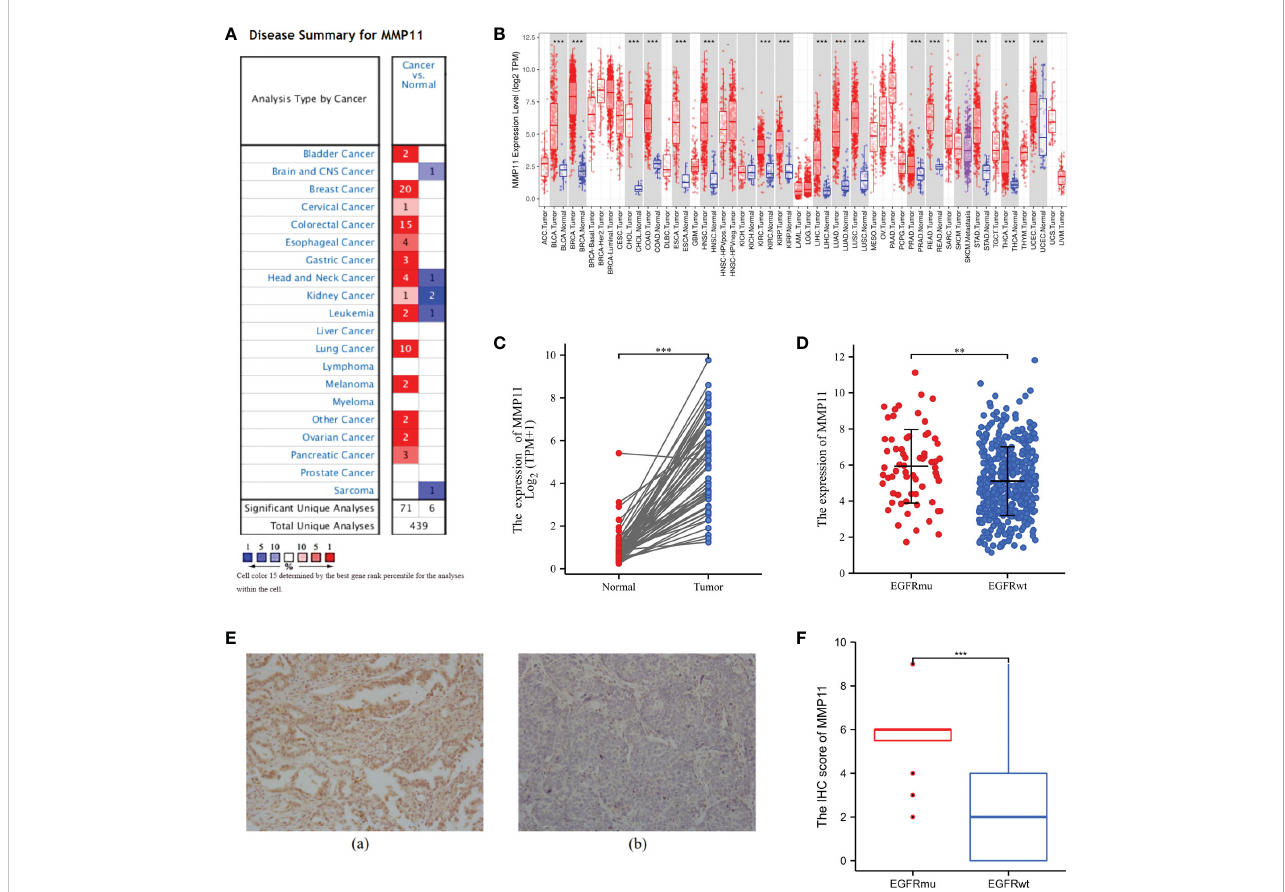
FIGURE 1 Differential expression of MMP11. (A) Differential expression of MMP11 in different tumor tissues and normal tissues in the Oncomine database; (B) Differential expression of MMP11 in different tumor tissues and normal tissues in the TIMER database; (C) Differential expression of MMP11 in LUAD tissues and paraneoplastic tissues in TCGA database; (D) Differences in MMP11 expression between EGFR-mutant group and EGFR-wild group in TCGA- LUAD database; (E) MMP11 immunohistochemical results of EGFR-mutant LUAD and EGFR wild-type LUAD tumor tissues: Positive MMP11 immunohistochemical staining (a) vs. negative staining (b) (400X); (F) Differences in IHC scores of MMP11 in LUAD tissues from EGFR-mutant group and EGFR-wild group; **P < 0.01; ***P <